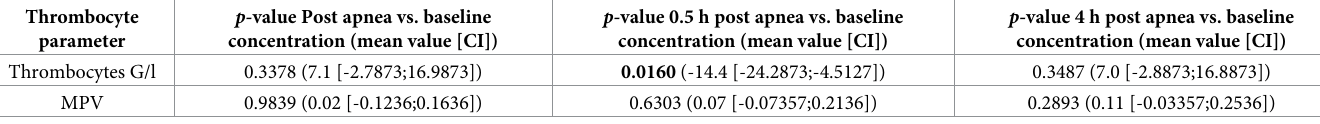
p -values, mean values and confidence intervals (CI) for change for the differences between the three time intervals post apnea, 0.5 h and 4 h post apnea versus baseline concentrations of thrombocytes and mean platelet volume. Significant p -values are marked in